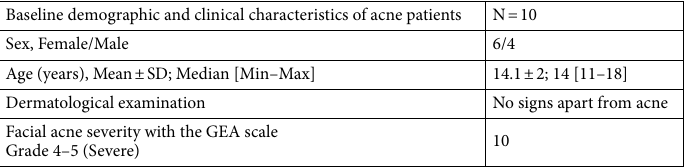
Table 1. Demographic and clinical characteristics of acne patients at